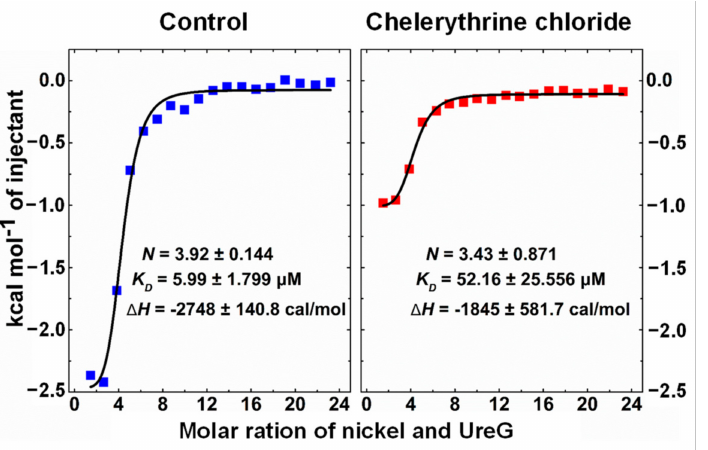
Figure 3. Isothermal titration calorimetry (ITC) enthalpograms of nickel binding to UreG with (right) or without (left) chelerythrine chloride. Titration data are presented as colored squares and fits as black solid lines. The molar ratio ( N ), equilibrium dissociation constant ( K D ) and enthalpy change ( ∆ H ) were shown in the